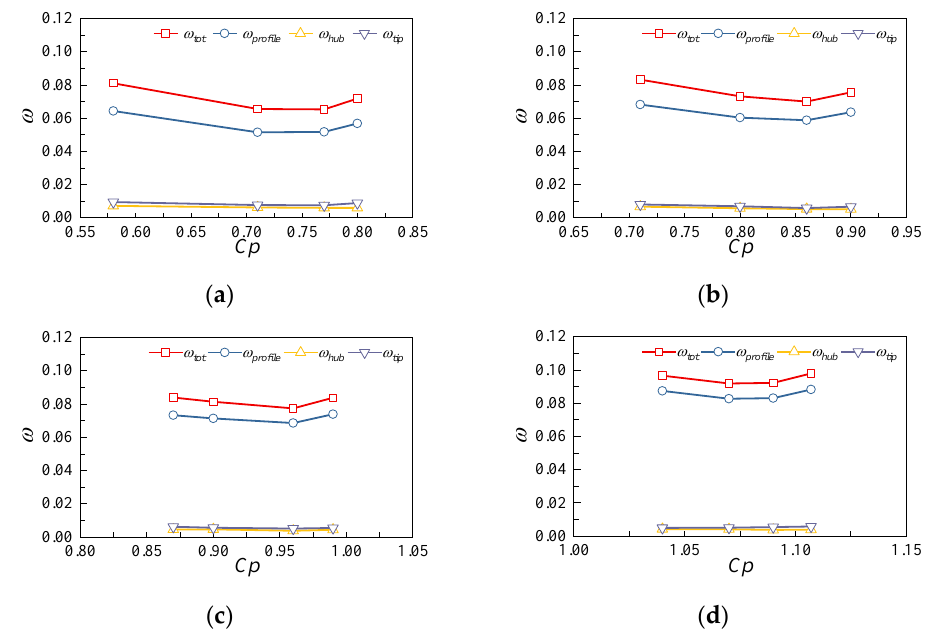
Figure 24. The distribution of pitch-averaged endwall loss for the stator blade: ( a ) ψ = 0.41; ( b ) ψ = 0.47; ( c ) ψ = 0.55; ( d ) ψ = 0.65.